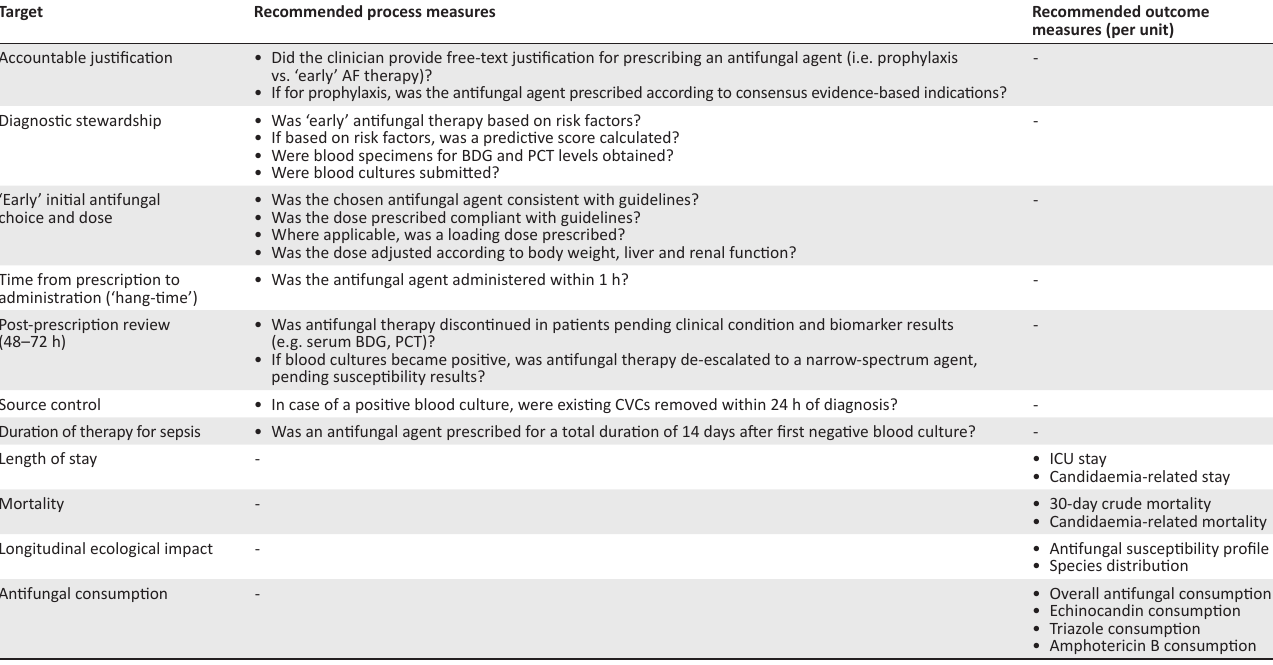
measures (per unit)